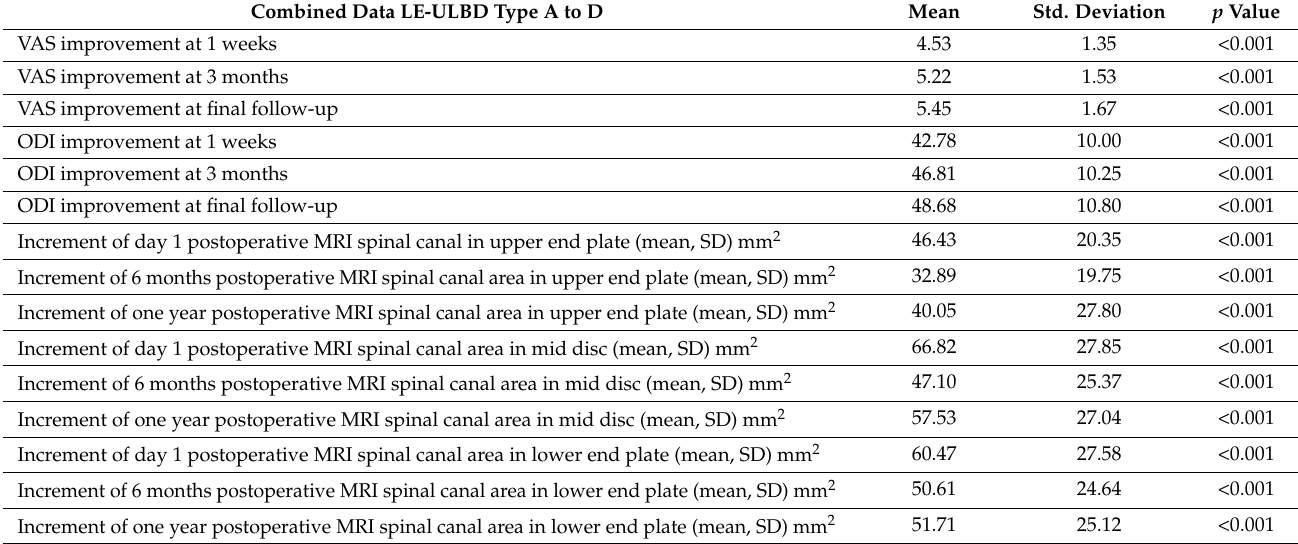
Table 3. Combined Clinical and Radiographic Parameters of Patients who underwent LE-ULBD with Four Types of Postoperative MRI canal remodeling. p -Value was derived from paired t -test.